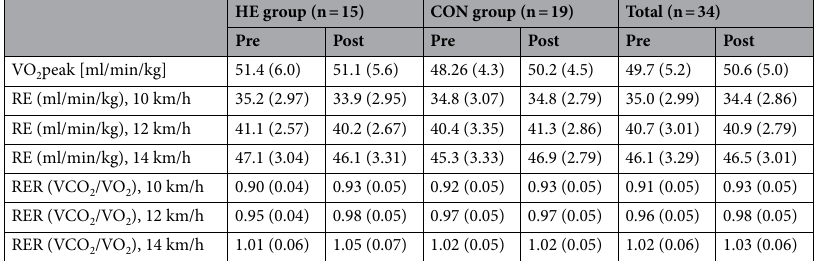
Table 3. Spiroergometric values (mean values and standard deviations). n number, kg kilograms, h hours, km kilometers, ml milliliters, min minutes, VO 2 oxygen intake, RE running economy, RER respiratory exchange ratio, VCO 2 carbon dioxide